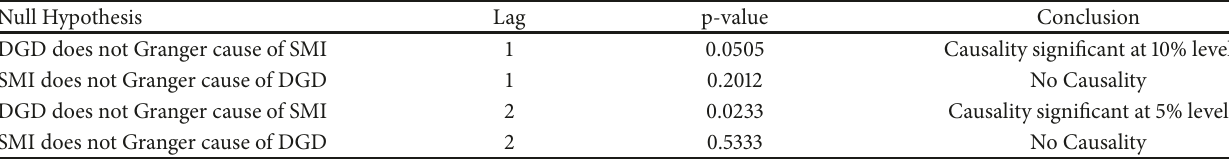
Table 5: Granger Causality Test Results.